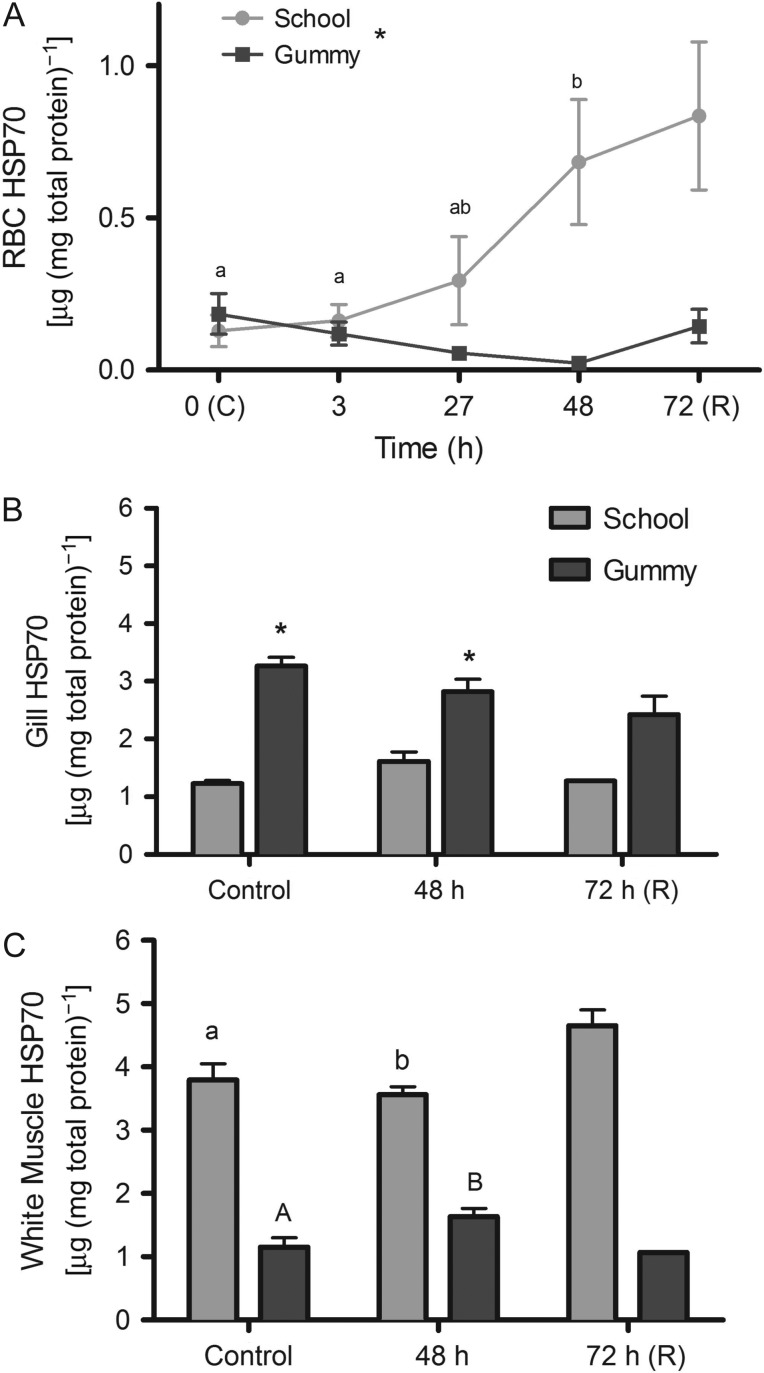
Heat-shock protein 70 (HSP70; in nanagrams of HSP70 per microgram of total
protein; mean values ± SEM) in school shark (G.
galeus) and gummy shark (M. antarcticus) red
blood cells (RBCs; A), gill (B) and white muscle
(C) following exposure to 75% seawater. Different
letters indicate statistically significant differences over time. Asterisk
indicates significant effect of species
(P < 0.05; see Materials and methods
for species replication numbers). Recovery data are not included in the
statistical analyses.